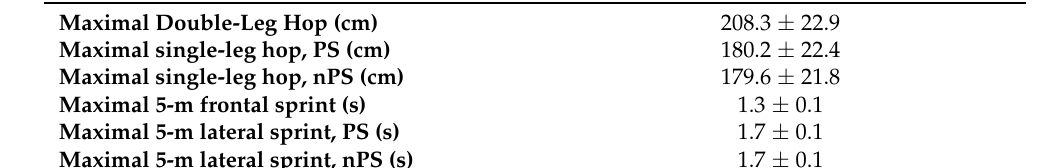
Table 3. Strength